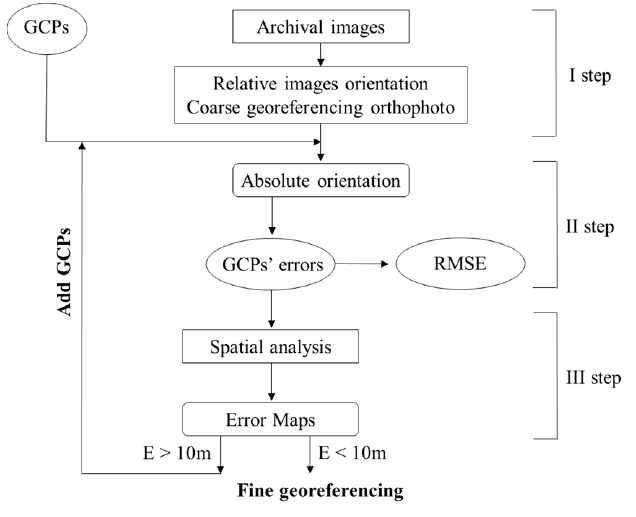
Figure 3. Methodology workflow. GCP, ground control point; RMSE, root mean square error.